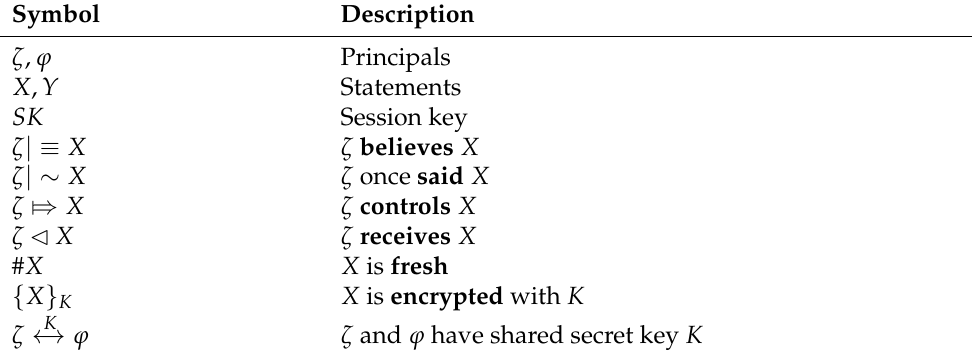
Table 2. BAN logic